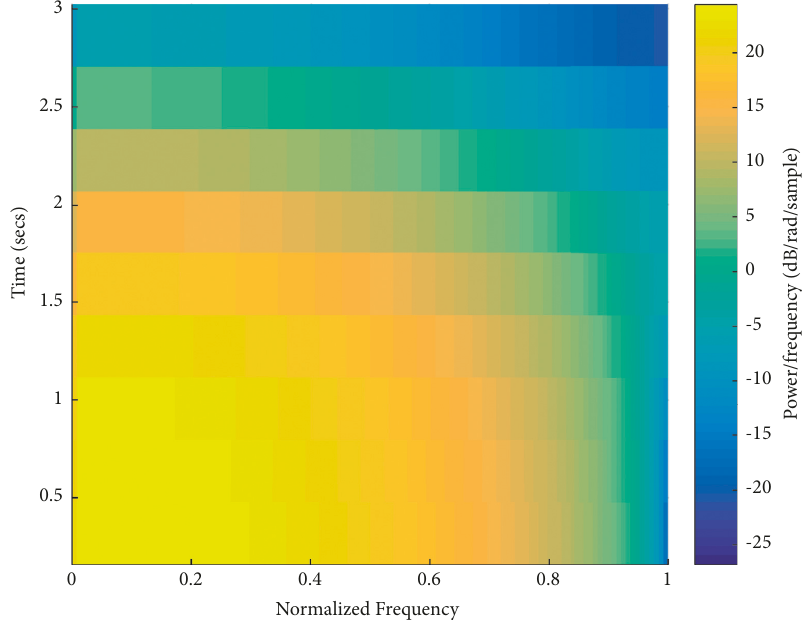
Figure 7: Time vs frequency.